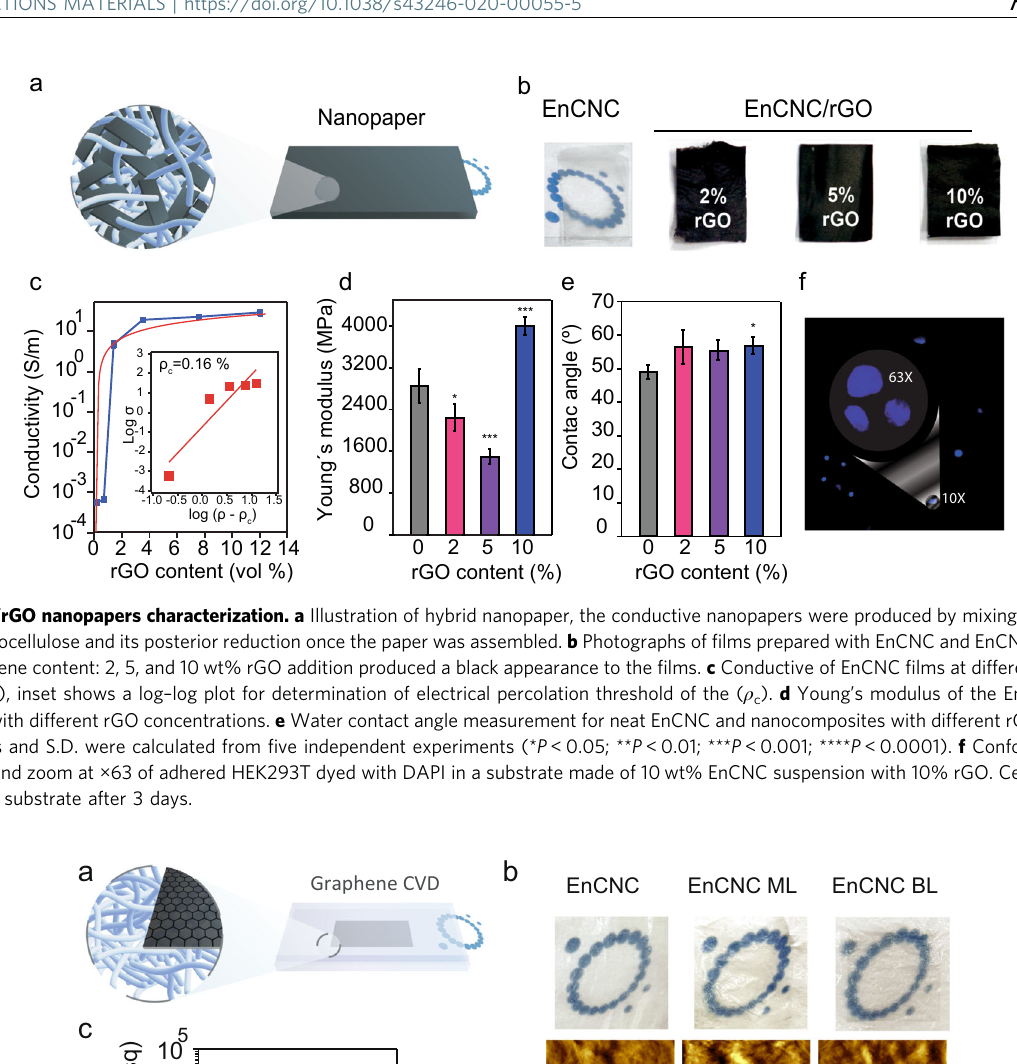
with a constant voltage were taken at 5, 0, and − 5 V, from both